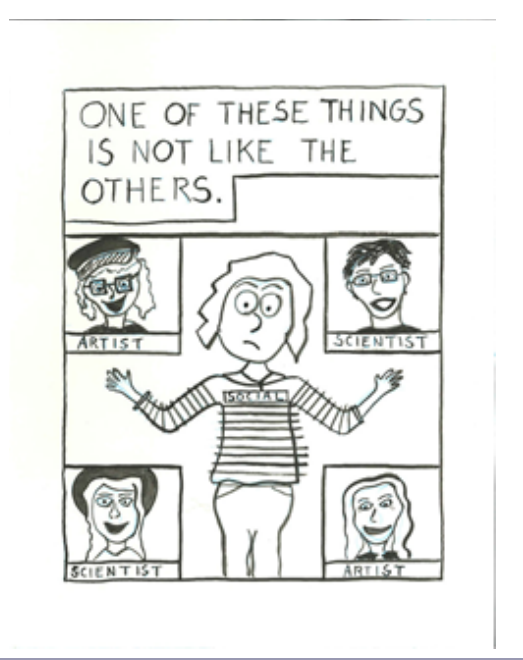
Fig. 5. “Are artists and scientists really so distinct?” Cartoon by Sigrid Peterson. For more illustrations, including photographs of young artists and scientists at a South American Institute for Resilience and Sustainability Studies workshop, see http://edgeeffects.net/confluence-